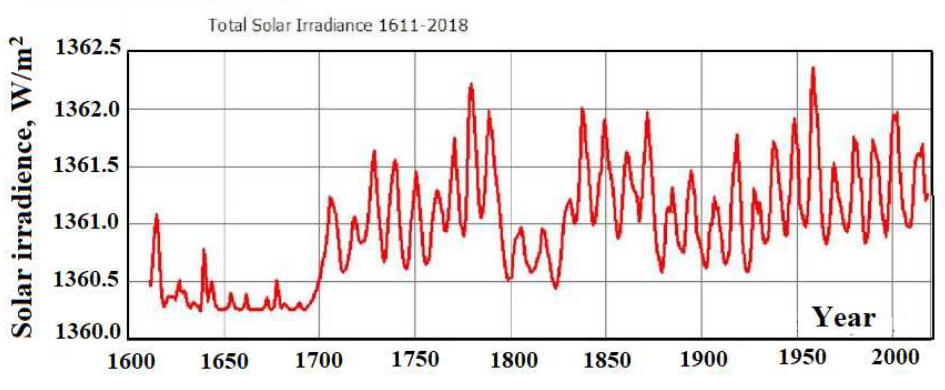
Figure 4. Evolution of the radiation flux generated by the Sun and entered in the Earth’s atmosphere over the past centuries